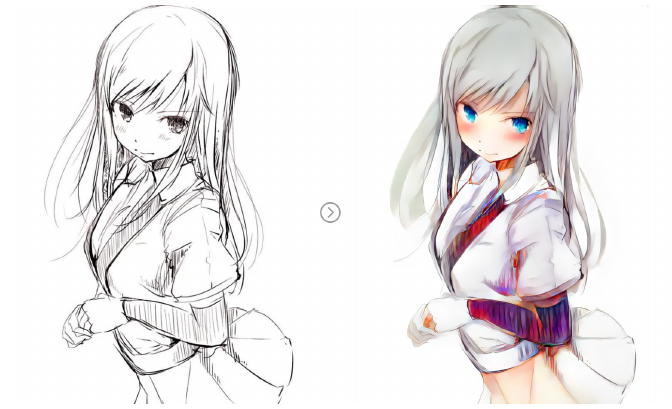
Figure 7. Example of colorization process based on style2paints. Image downloaded from